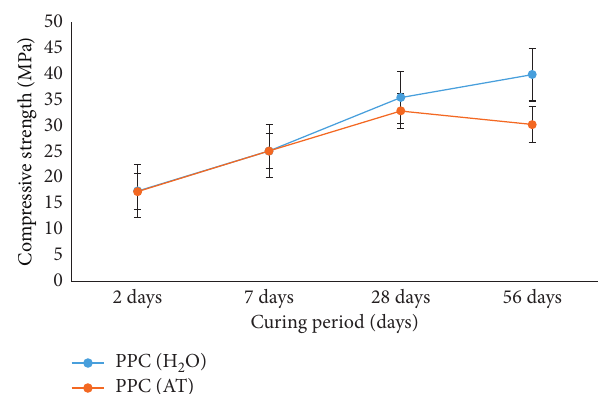
Figure 6: Compressive Strength results for control and microbially treated PPC.